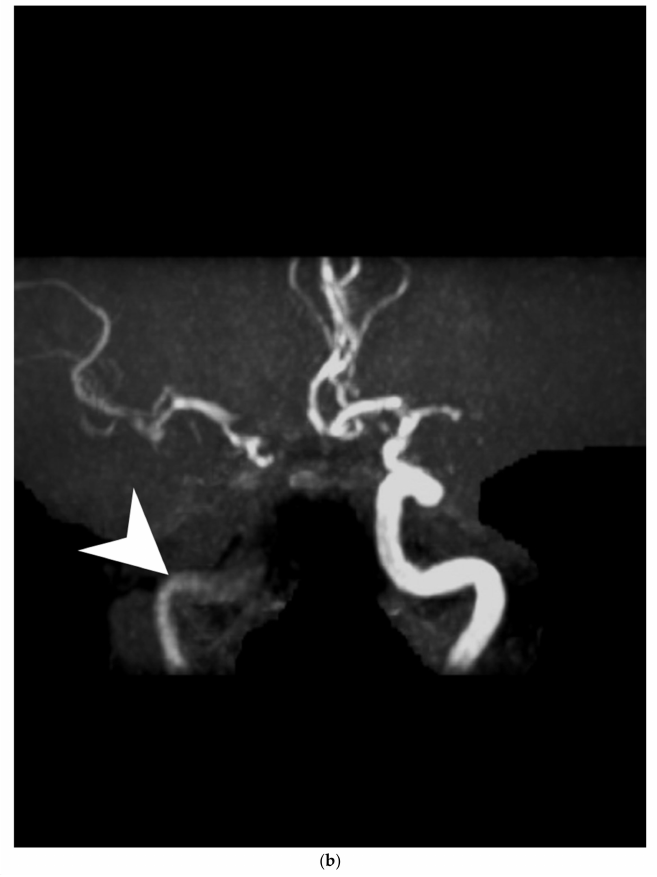
Figure 1. A 45-year-old male presented with acute-onset left-sided weakness and slurred speech. The clinical diagnosis of stroke was based on focal neurologic deficits, persistent symptoms, and an abrupt clinical course. Non-contrast brain magnetic resonance images revealed border-zone infarcts (Figure 1a). Magnetic resonance angiography (MRA) disclosed trivial flow in the right internal carotid artery (Figure 1b). A survey of the ischemic stroke risk factors in young adults excluded coagulopathy, vasculitis, hematologic and cardiac disease. A history of heavy smoking (two packs a day for the last 27 years), hypertension, and dyslipidemia (low-density lipoprotein: 143 mg/dL) were noted during stroke workup. Nevertheless, neck computed tomography angiography (CTA) revealed a long-segmental narrowing of the right internal carotid artery with wall thickening and a “string-of-beads” appearance suspicious for fibromuscular dysplasia (FMD), which was confirmed on further angiography (Figure 2). Adequate hydration, aspirin, and statin were prescribed for secondary stroke prevention. His clinical condition stabilized after intensive medical therapy. ( a ). On diffusion-weighted images, the cortical and internal border-zone ischemic infarcts are visualized with hyperintense lesions. ( b ). On magnetic resonance angiography image, the flow signal intensity of the right proximal internal carotid artery is severely reduced with trivial blood flow (white arrowhead). Complete occlusion of the right distal internal carotid artery and left middle cerebral artery are also